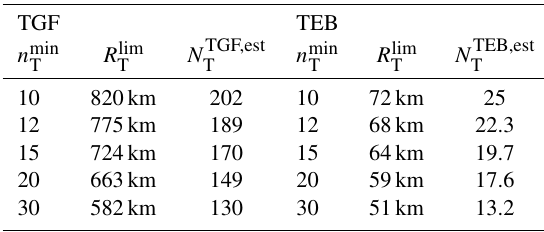
(cid:16) (cid:17) R lim and the TGF / TEB detection rate T